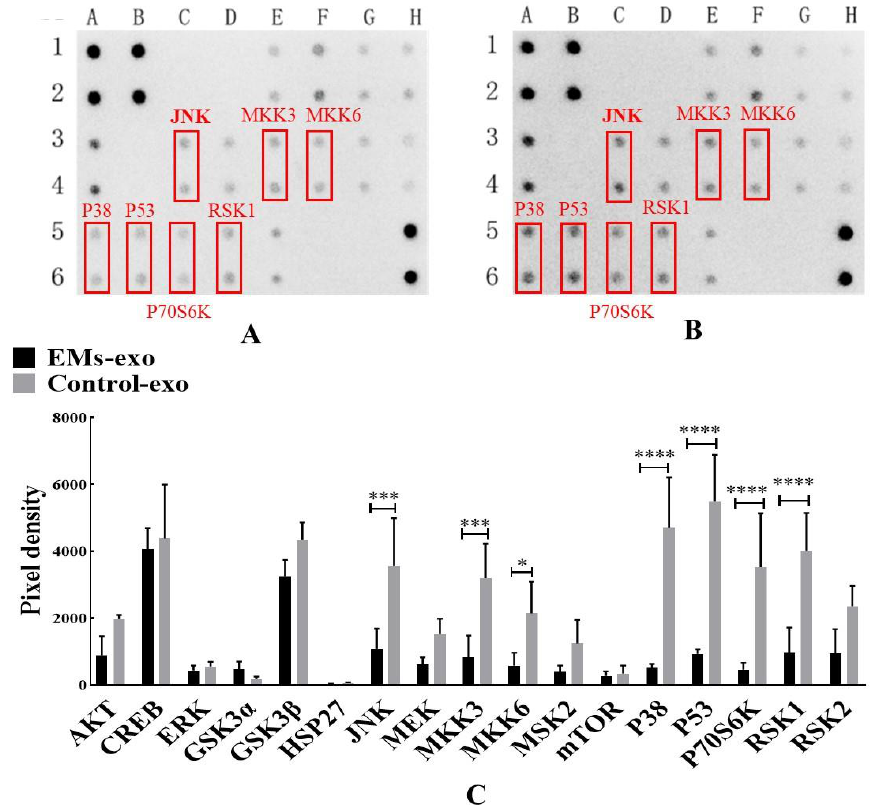
Figure 4. Exosomes of the uterine aspirate fluid influence the MAPK pathway phosphorylated proteins in macrophages. ( A ) The expression of MAPK pathway phosphorylated proteins after inter- vention with exosomes from the EMs group. ( B ) The expression of MAPK pathway phosphorylated proteins after intervention with exosomes from the control group. ( C ) The differentially expressed MAPK pathway phosphorylated proteins. The red box represents the differentially expressed pro- teins compared with the control. Data are expressed as the mean ± SEM (* p < 0.05, *** p < 0.001, **** p < 0.0001).